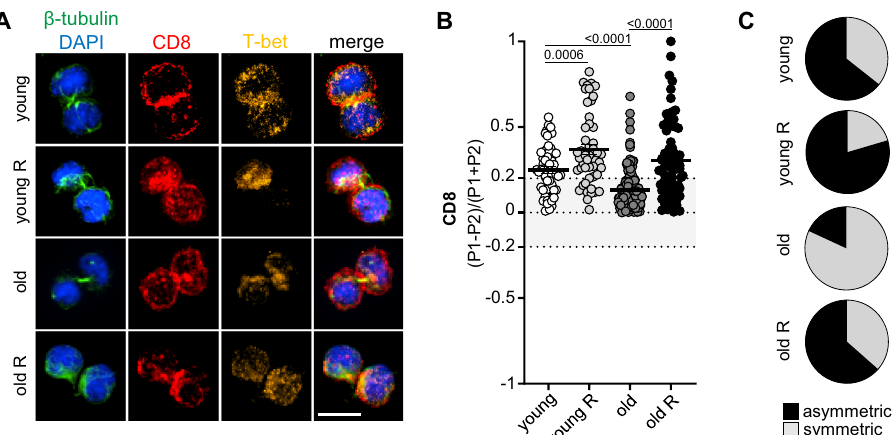
Fig. 1 CD8 + T cells from aged mice exhibit decreased ability to undergo asymmetric cell division. A Confocal images of murine CD8 + T cells fi xed 36 – 40 h after in vitro stimulation on α -CD3, α -CD28 and human Fc-ICAM-1 coated wells (young, n = 59; young R, n = 49; middle-aged/old, n = 171; middle-aged/old R, n = 74). Transient mTOR inhibition was achieved by treatment with rapamycin (R) (20 nM). Cells were exposed to drug treatment from 12 h post activation until fi xation for confocal microscopy analysis. Scale bar = 10 µ m. B ACD rates observed in CD8 + T cells from middle-aged/aged and young mice upon transient mTOR inhibition with rapamycin. Data are represented as mean ± SEM. C Pie charts indicating frequencies of asymmetrically dividing cells from B . Level of CD8 asymmetric inheritance is depicted in black and level of CD8 symmetric inheritance in grey. Pooled data from three independent experiments. Age of the animals: experiments 1 and 2 (40 – 43 weeks) and experiment 3 (71 weeks). Statistical analysis was performed using the unpaired two-tailed Student ’ s t test. Exact P values are depicted in the fi gure (see also Supplementary Fig.